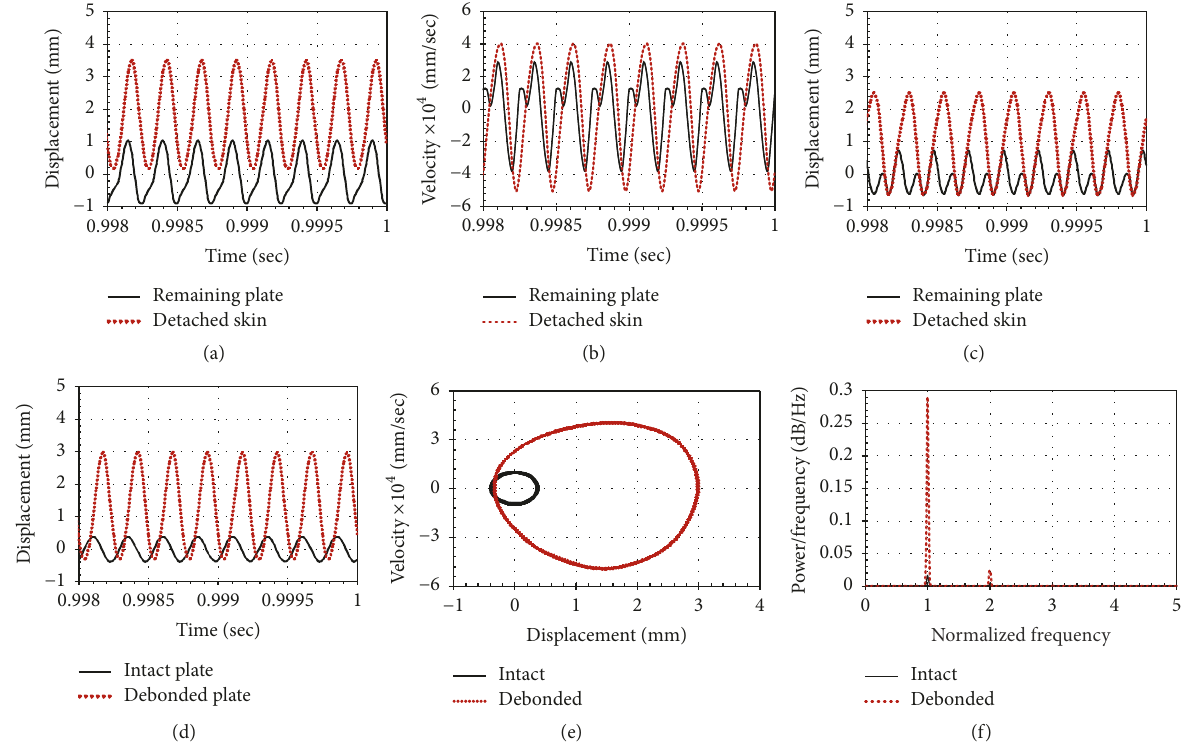
Figure 26: Steady-state dynamic response at 𝜂 = 4(Ω = 4000 Hz ) : ((a)-(b)) displacement and velocity time histories at points N2 and N3; (c) displacement time histories at points N4 and N5 [80]; (d) displacement time histories at point N1 [80]; (e) phase portrait at point N1 [80]; and (f) frequency spectra of the displacement signals at point